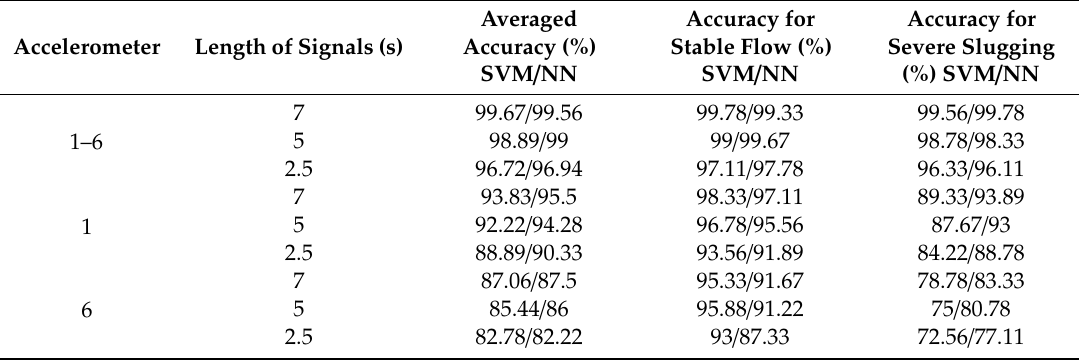
Table 5. Binary classification results of the SVM and NN including controlled stable regime. Accelerometer Length of Signals (s)